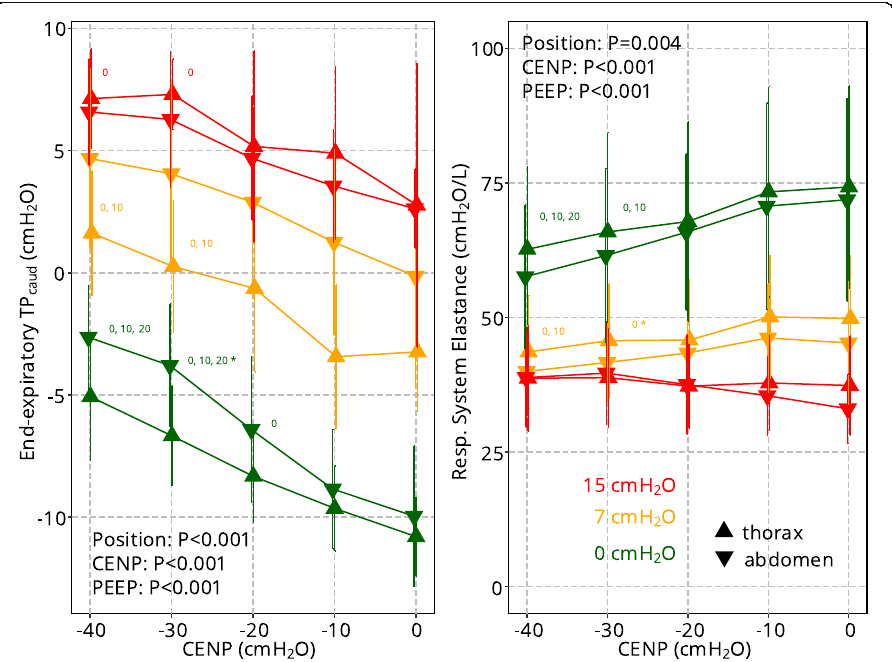
Fig. 2 End-expiratory caudal transpulmonary pressure (left) and respiratory system elastance (right). Legend: CENP, continuous external negative pressure; PEEP, positive end-expiratory pressure. Triangles indicate different shell positions (abdomen and thorax), colours represent different PEEP levels, super-posed numbers indicate significance ( P < 0.05) of the respective CENP level compared with the CENP level of the number and stars indicate difference between both